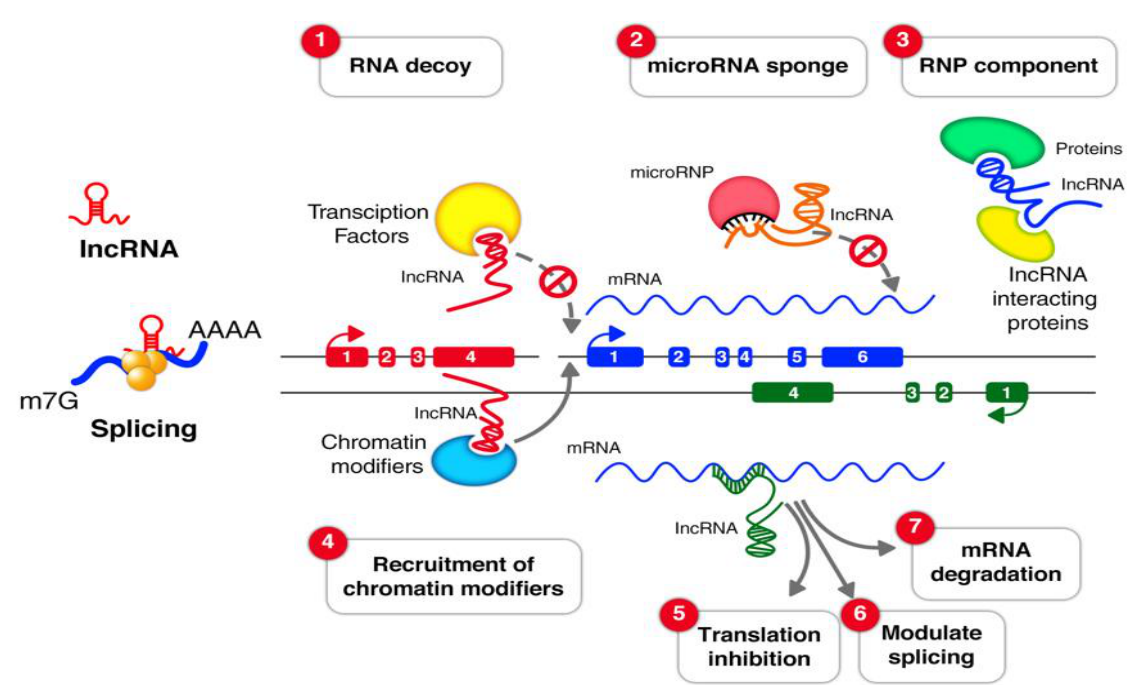
Figure1: The lncRNA mechanisms of action. (1) RNA decoys; lncRNAs can act as decoys for transcrip- tion factors and sequester them away from their targets. (2) microRNA sponge; LncRNAs can bind to microRNAs as sponges to prevent them from their regulatory function. (3) Ribonucleoprotein (RNP) component; LncRNAs can play scaffolding roles to aid in the formation of Ribonucleoprotein (RNP) complexes. (4) Recruitment of chromatin modifiers; LncRNAs can recruit different kind of protein com- ponents which change the patterns of chromatin organization. LncRNAs can modulate (5) translation inhibition (6) , splicing (7) and mRNA